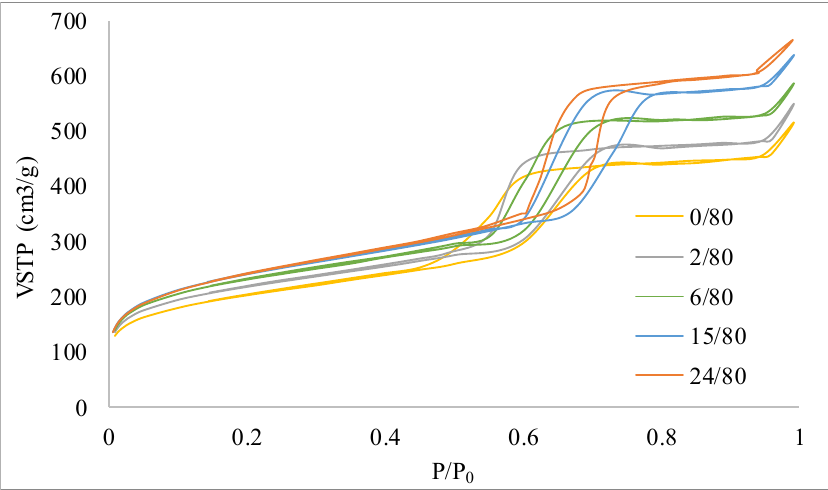
Figure 5. N 2 adsorption isotherms corresponding to the samples 0/80, 2/80, 6/80, 15/80, and 24/80.